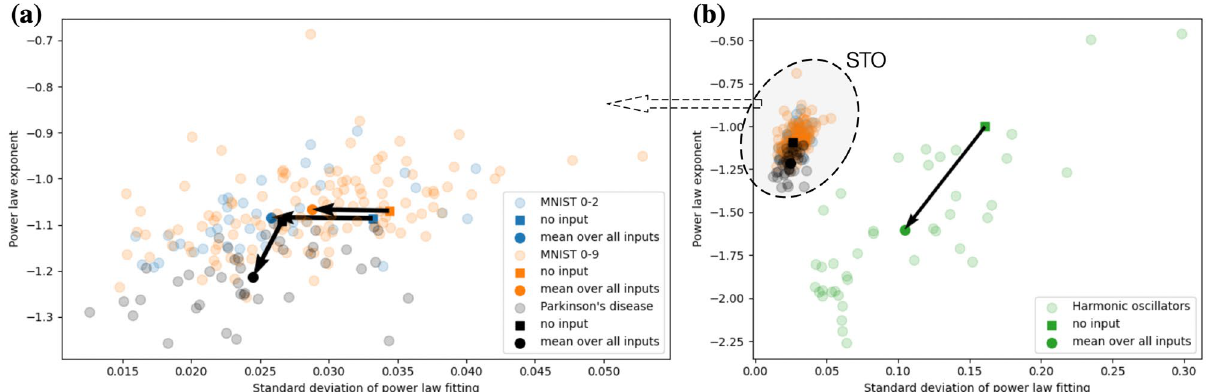
Figure 9. Power law exponent and standard deviation of the power law fitting for different tasks, inputs, and networks from Table 1. Figure ( a ) is a zoom-in of a region from Figure ( b ) that corresponds to the STO network. In all cases, the trained networks exhibit criticality signatures, and the standard deviation of the power law fitting decreases under the external